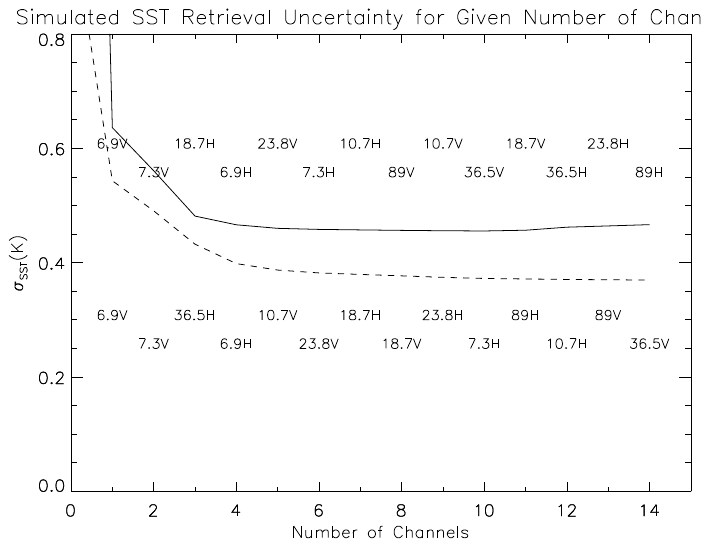
Figure 9. The standard deviation of the SST retrieval error for the best combination of the given number of channels from simulated retrievals. The additional channel added to the set is indicated at each step. The upper set of channels and solid line assume a four-variable retrieval vector and the lower set and dashed line assume a five-variable retrieval vector. Table 1. The standard deviation of the sea surface temperature (SST) retrieval error and root-mean-squared predicted SST uncertainty from an information content analysis across all profiles for varying numbers of channels. The channel indicated on each row is the best one to add to the existing channel set for retrieving